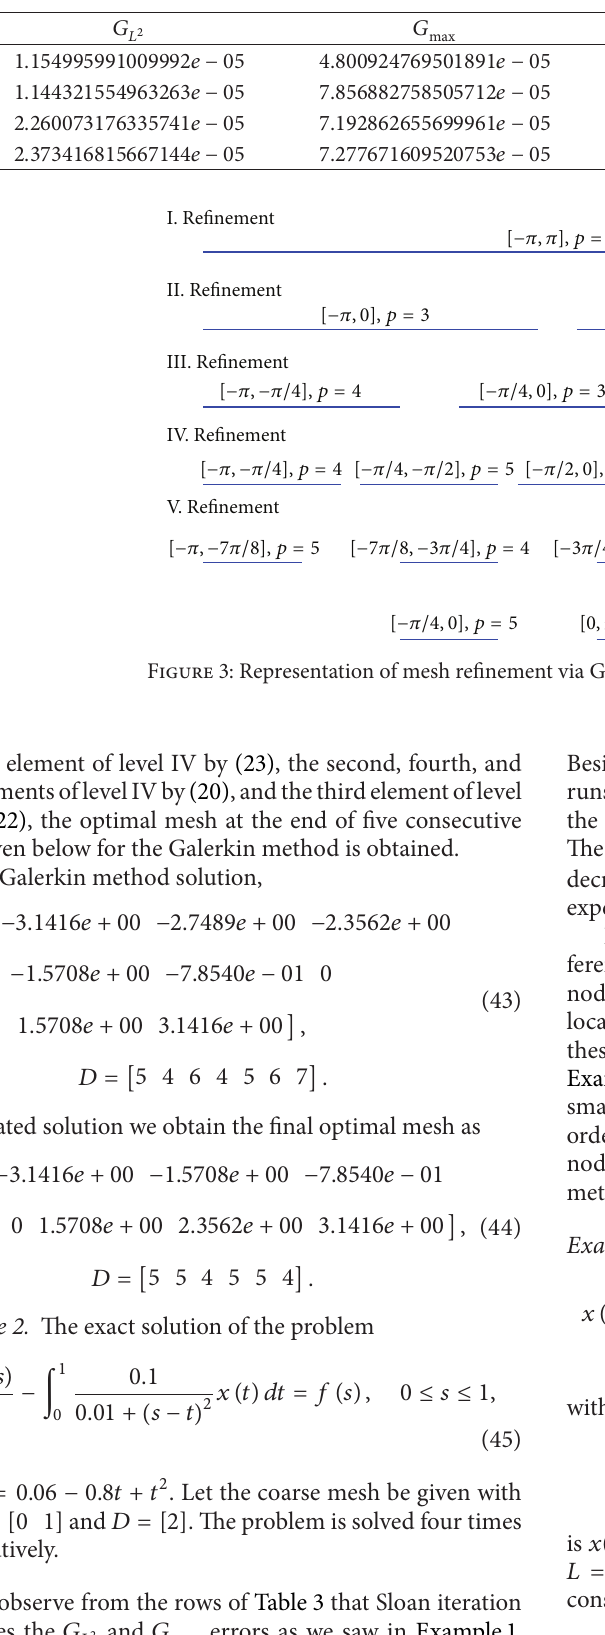
Table 3: Error values of (45) in Example 2.